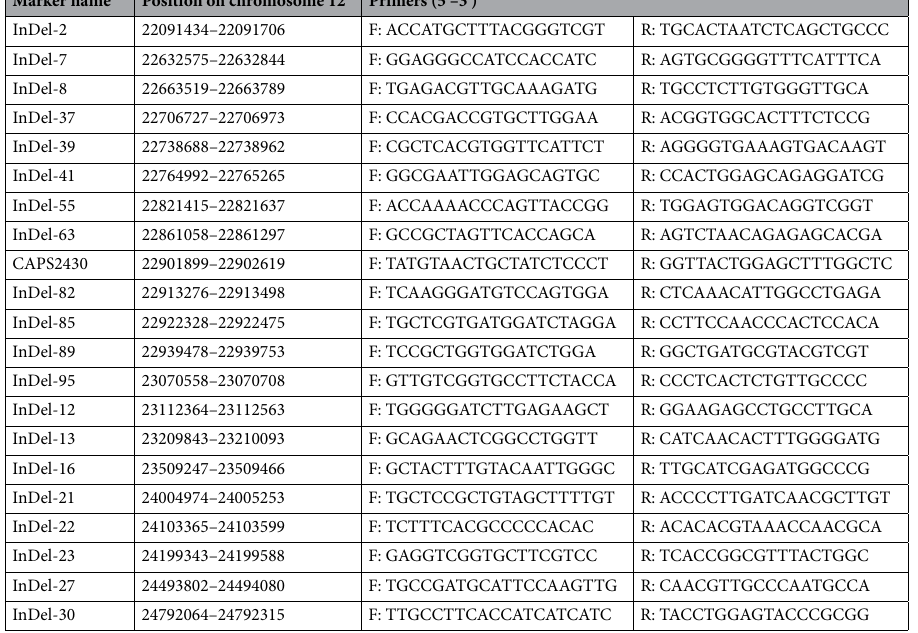
Table 1. Primers of markers used in gene mapping and marker efficiency analysis.